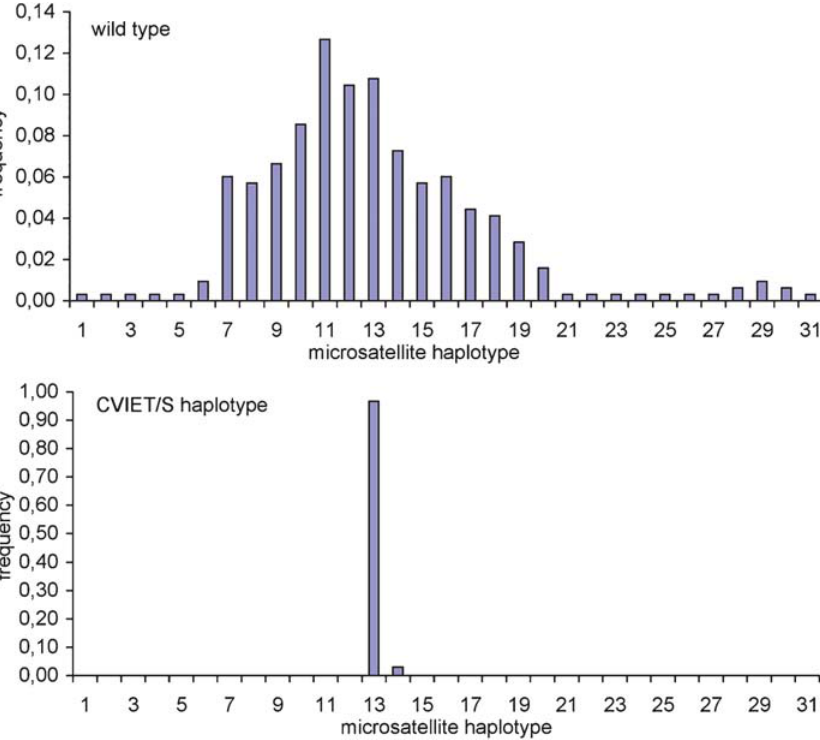
Figure 4. Frequency distribution of Pfcrtintron 4 microsatellite types by codons 72–76 and 220 haplotype. 247 isolates were typed (19, 23, 22, 33, 28, 22, 29, 17, 39 and 15 isolates in 1990, 1991, 1992, 1993, 1994, 1995, 1996, 1997, 1998 and 1999, respectively) for the intron 4 microsatellite by gene sequencing (see Materials and Methods). There were 31 CVIETS haplotypes and 216 wild type haplotypes. The haplotype codes are listed in Table